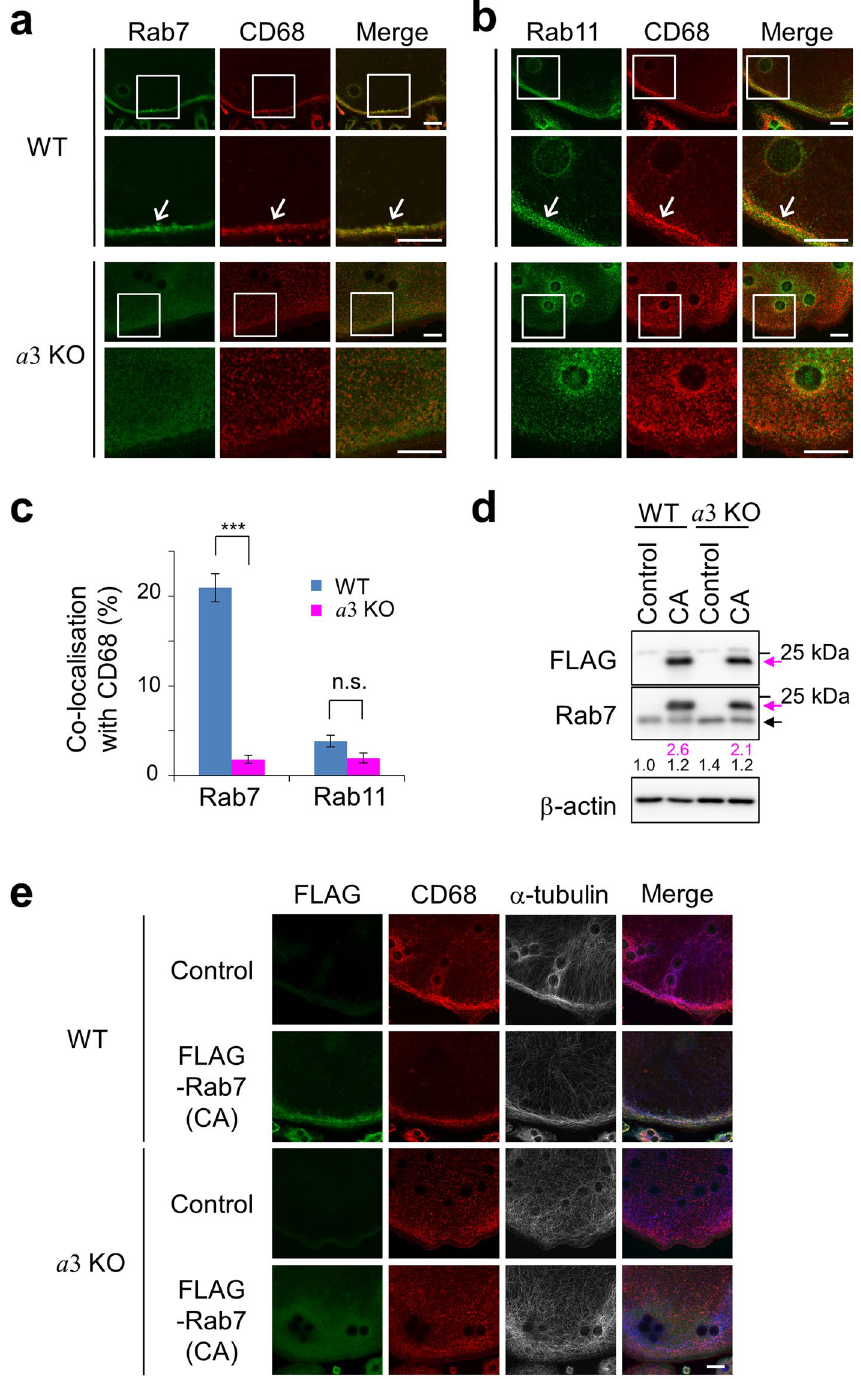
Figure 7. Localisations of Rab proteins and CD68 in osteoclasts. ( a , b ) Localisations of CD68, Rab7 and Rab11 in osteoclasts. Osteoclasts derived from wild-type (WT) and a 3-knockout ( a 3KO) macrophages were stained with antibodies against CD68 (red) and Rab7 ( a , green) or Rab11 ( b , green). Representative images are shown, together with merged images (Merge). The boxed areas are magnified in the lower panels. The images are representative of at least ten cells. Bars indicate 20 μ m. ( c ) Co-localisation of CD68 and Rab7 or Rab11. Co- localisation is quantified as the percentage of CD68-positive pixels that were also Rab protein-positive. Blue and magenta bars indicate osteoclasts derived from wild-type and a 3-knockout macrophages, respectively. At least five osteoclasts were examined per experiment. Data are means ± s.e.m.; *** p < 0.0005; n.s., not significant (unpaired two-tailed Student’s t -test). ( d ) Expression of constitutively active FLAG-Rab7. Wild-type (WT) and a 3-knockout ( a 3KO) macrophages were infected with a retrovirus expressing constitutively active FLAG-Rab7 and then cultured in the presence of RANKL for 6 days to induce osteoclast differentiation. Lysates of these osteoclasts were prepared and analysed by SDS-polyacrylamide gel electrophoresis and Western blotting